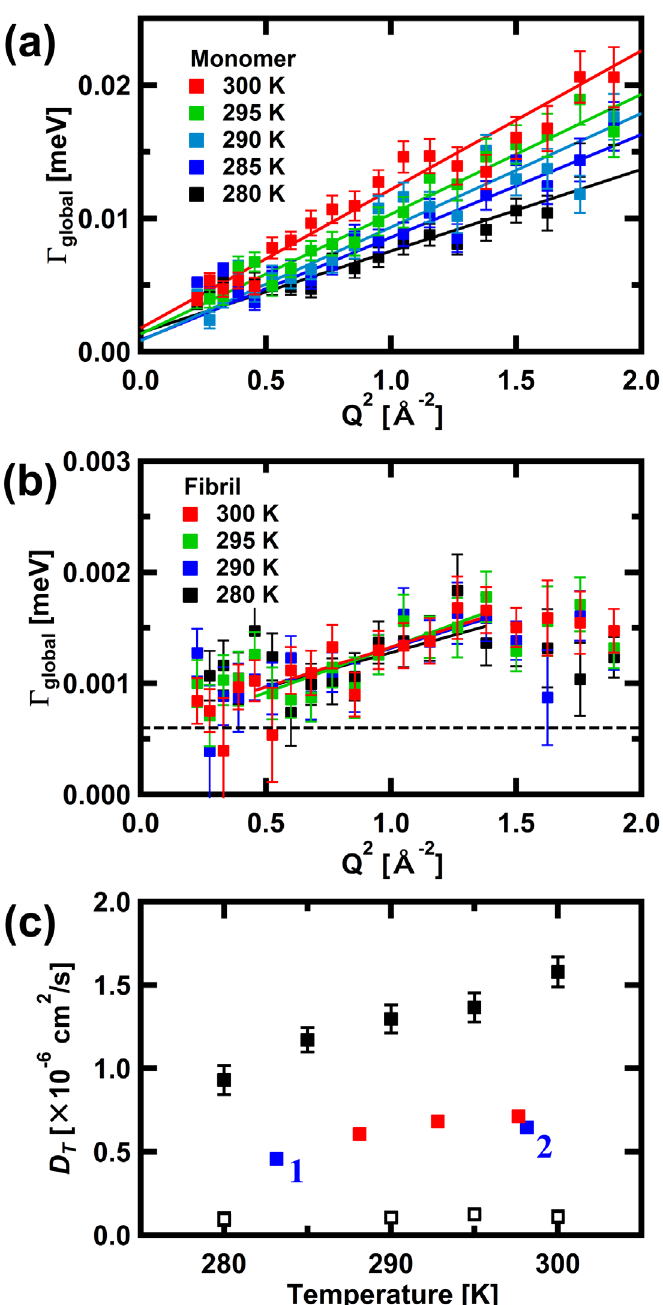
Fig 2. Variations in the HWHM, Γ global , of L global (Q, ω ) as a function of Q 2 for α Syn in (a) the monomeric state and (b) the fibril state. Solid lines are the linear fits to the data, the slopes of which provide estimates of the effective diffusion coefficients, D T . The dashed line in (b) is 1/10 × HWHM for the resolution function. The error bars are within in symbols where not shown. (c) Summary of D T for α Syn. Filled and open squares in black are for the monomeric state and the fibril state, respectively. The filled squares in blue with subscripts 1 and 2 are the D T values estimated for α Syn in solution, reported in Refs. 40 and 41, respectively. Note that these values were corrected for the differences in solvent viscosity due to the different D 2 O concentration in the samples for the NMR measurements (6% and 10% D 2 O for Refs. 40 and 41, respectively) and the QENS measurements (100% D 2 O) in this study. Filled squares in red denote the D T values estimated from the DLS measurements on the α Syn solution under the condition similar to that employed for the QENS measurements (9.0 mg/ml α Syn in the PBS buffer in D 2 O) done in this